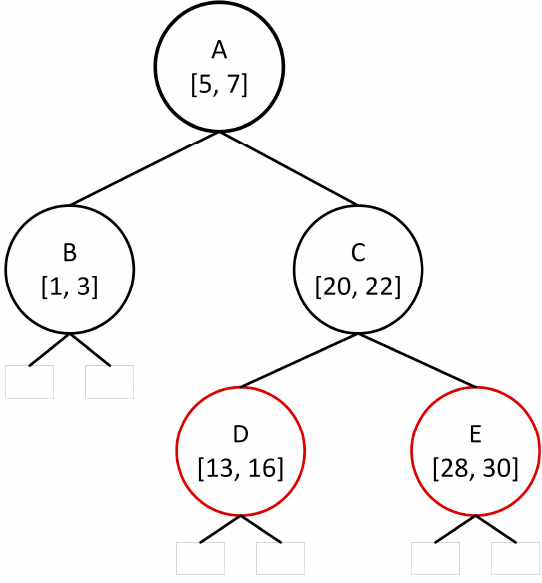
Figure 7. Example red–black tree of a cube.